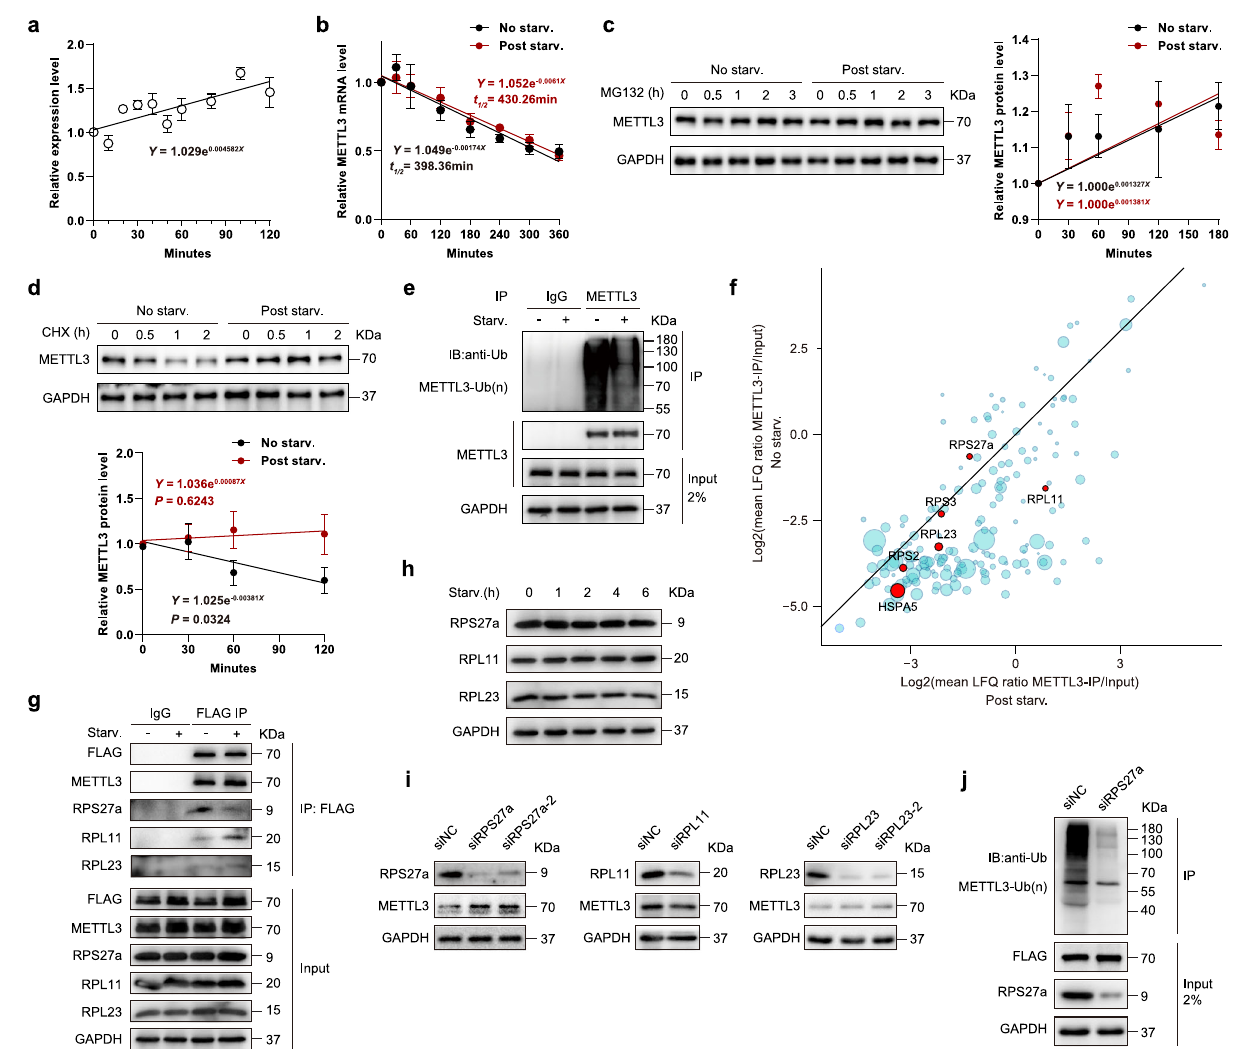
Fig. 4 | Inhibited RPS27a-METTL3 interaction stabilizes METTL3 under starva- tion. a qRT-PCR analysis of METTL3 in MEFs following nutrient starvation for the indicatedtimeperiods( n =4biologicalreplicates). b MEFsweretreatedwithAct.D (5 μ g/mL) for the indicated times with or without nutrient starvation,